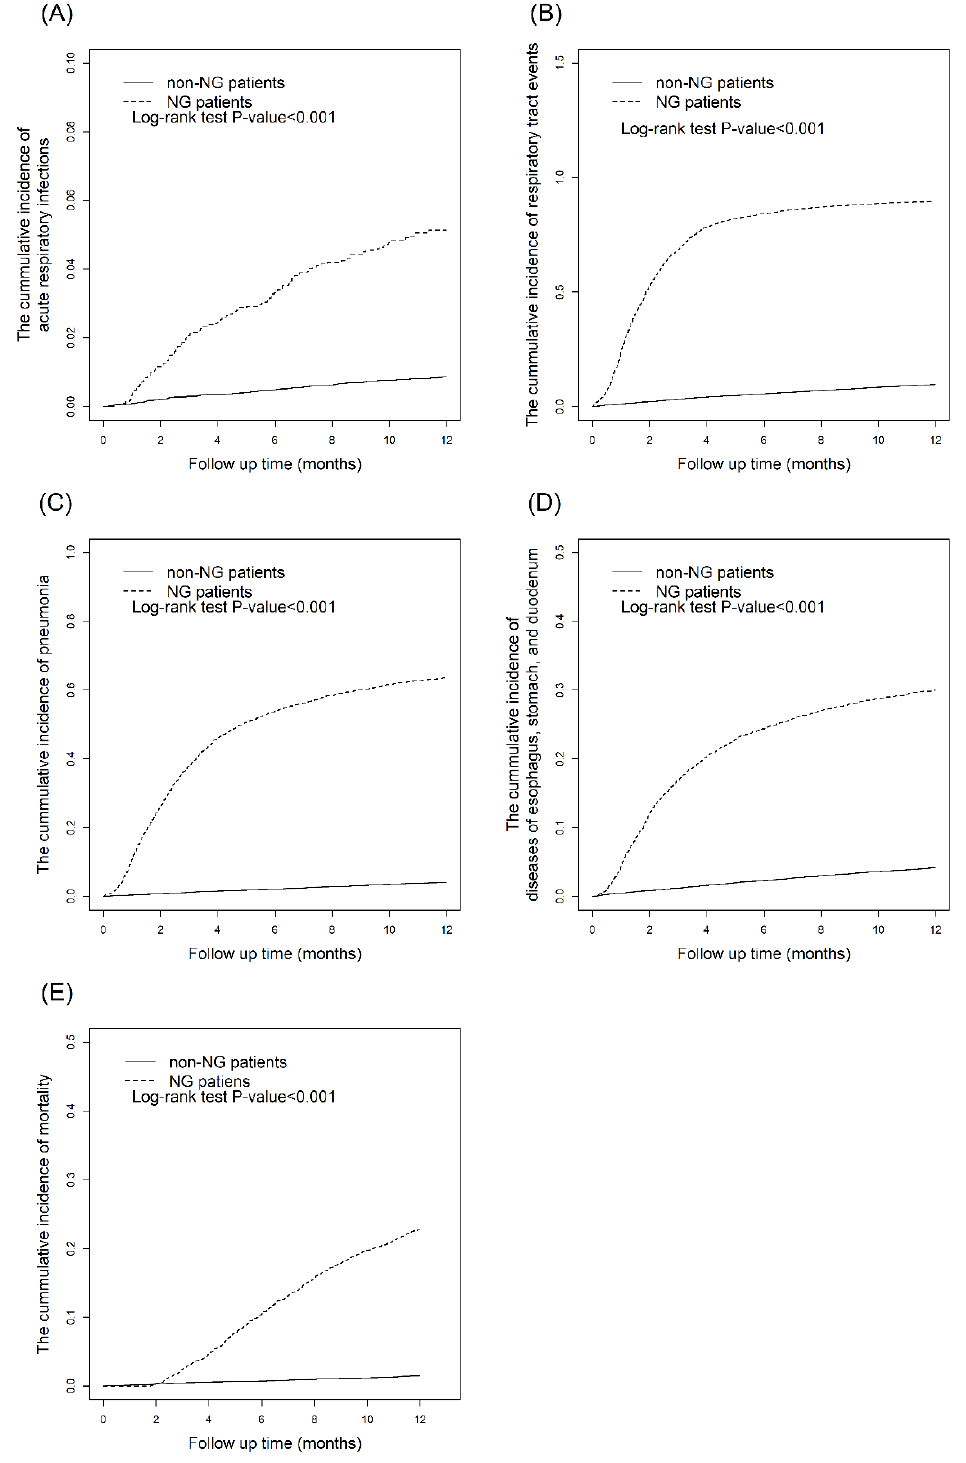
Figure 3. Kaplan–Meier curves for the cumulative incidences of outcomes within one year in NGT placement cohort and non-NGT placement cohort: ( A ) Acute and chronic respiratory infections. ( B ) Acute respiratory infections. ( C ) Pneumonia. ( D ) Diseases of esophagus, stomach, and duodenum. ( E ) Mortality.